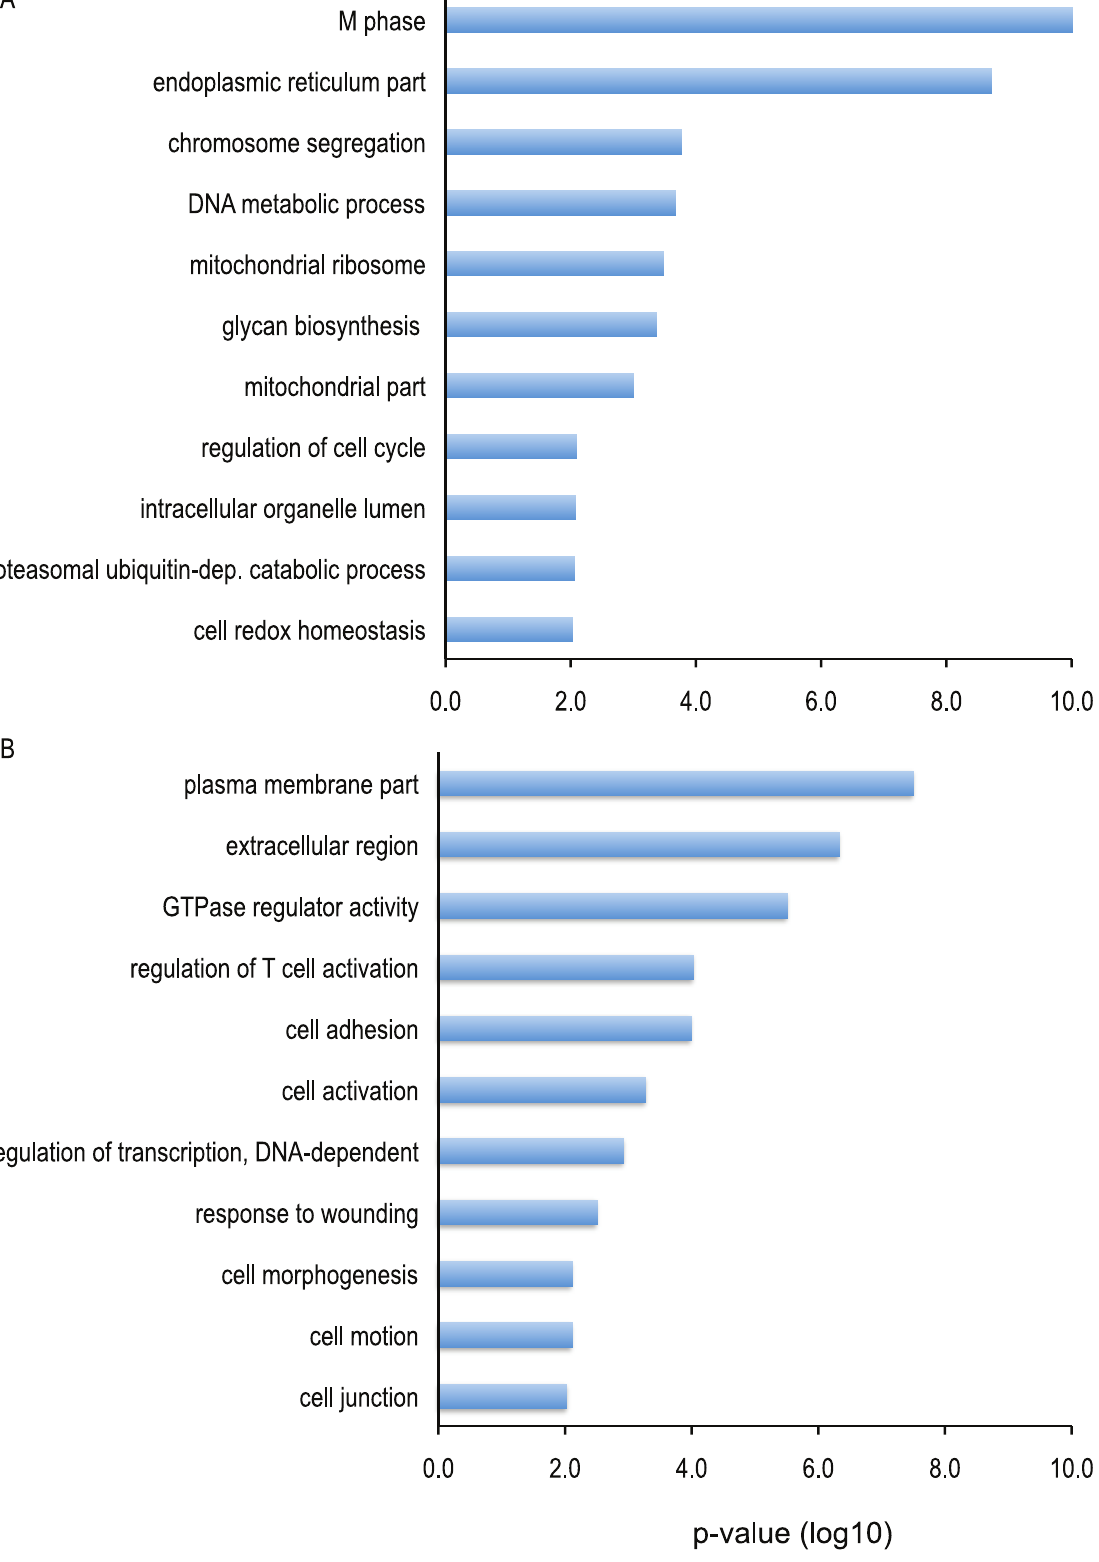
Figure 2. Gene ontologies associated with principal component 1 on fever day 4. Significant clusters of gene ontologies were identified using DAVID; only the most significant term in each GO cluster is shown, and only those with a p-value # 0.01. A) GO terms associated with a low PC1 score (DF2,DHF,DSS . DF1 . H). B) GO terms associated with a high PC1 score (H . DF1 . DF2,DHF,DSS). doi:10.1371/journal.pntd.0001966.g002 PLOS Neglected Tropical Diseases | www.plosntds.org